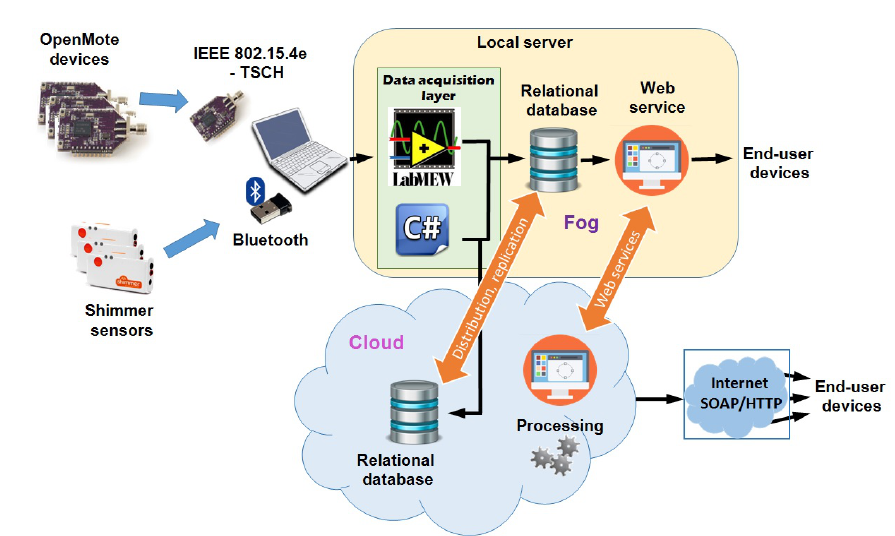
Figure 1. Heterogeneous Internet of Things (IoT)-based architecture for remote healthcare monitoring. Reproduced from